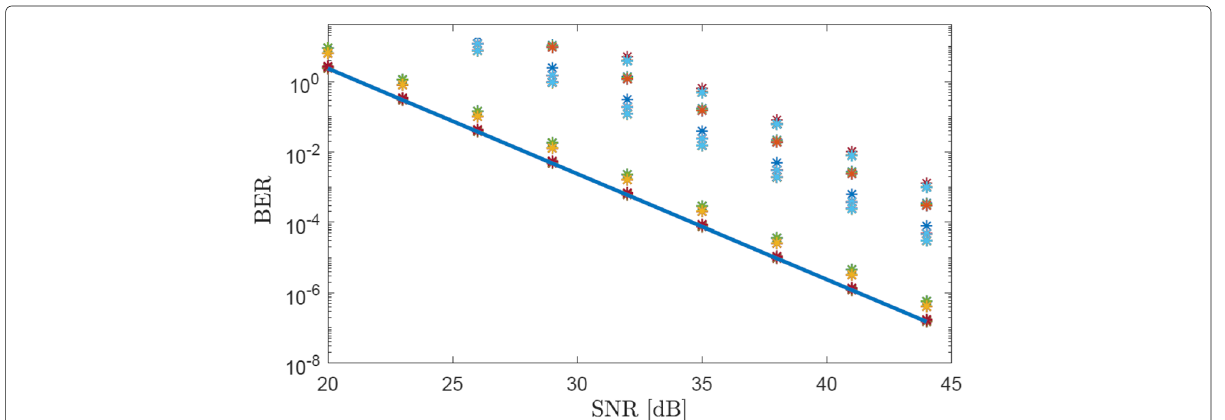
Fig. 12 ABEP of RecAnt-SSK ( P = 4, N r = 3). The different markers show the ABEP by choosing four RPs out of eight RPs in order to identify